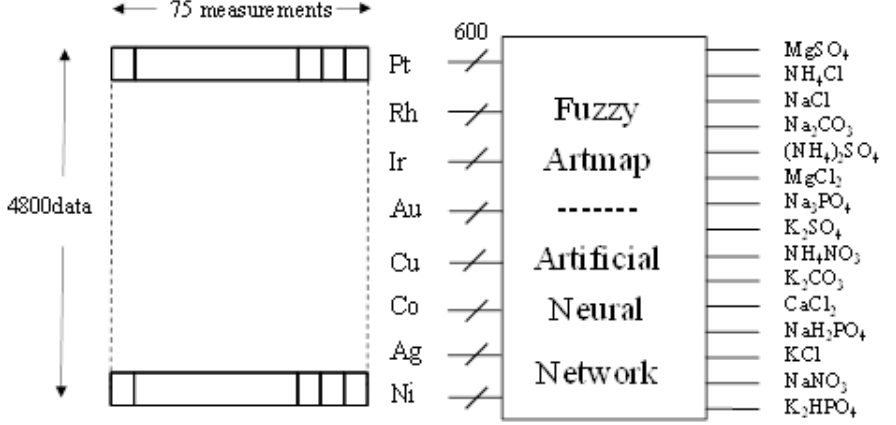
Figure 5. Classification of measures by Artificial Neural Networks accord the fifteen